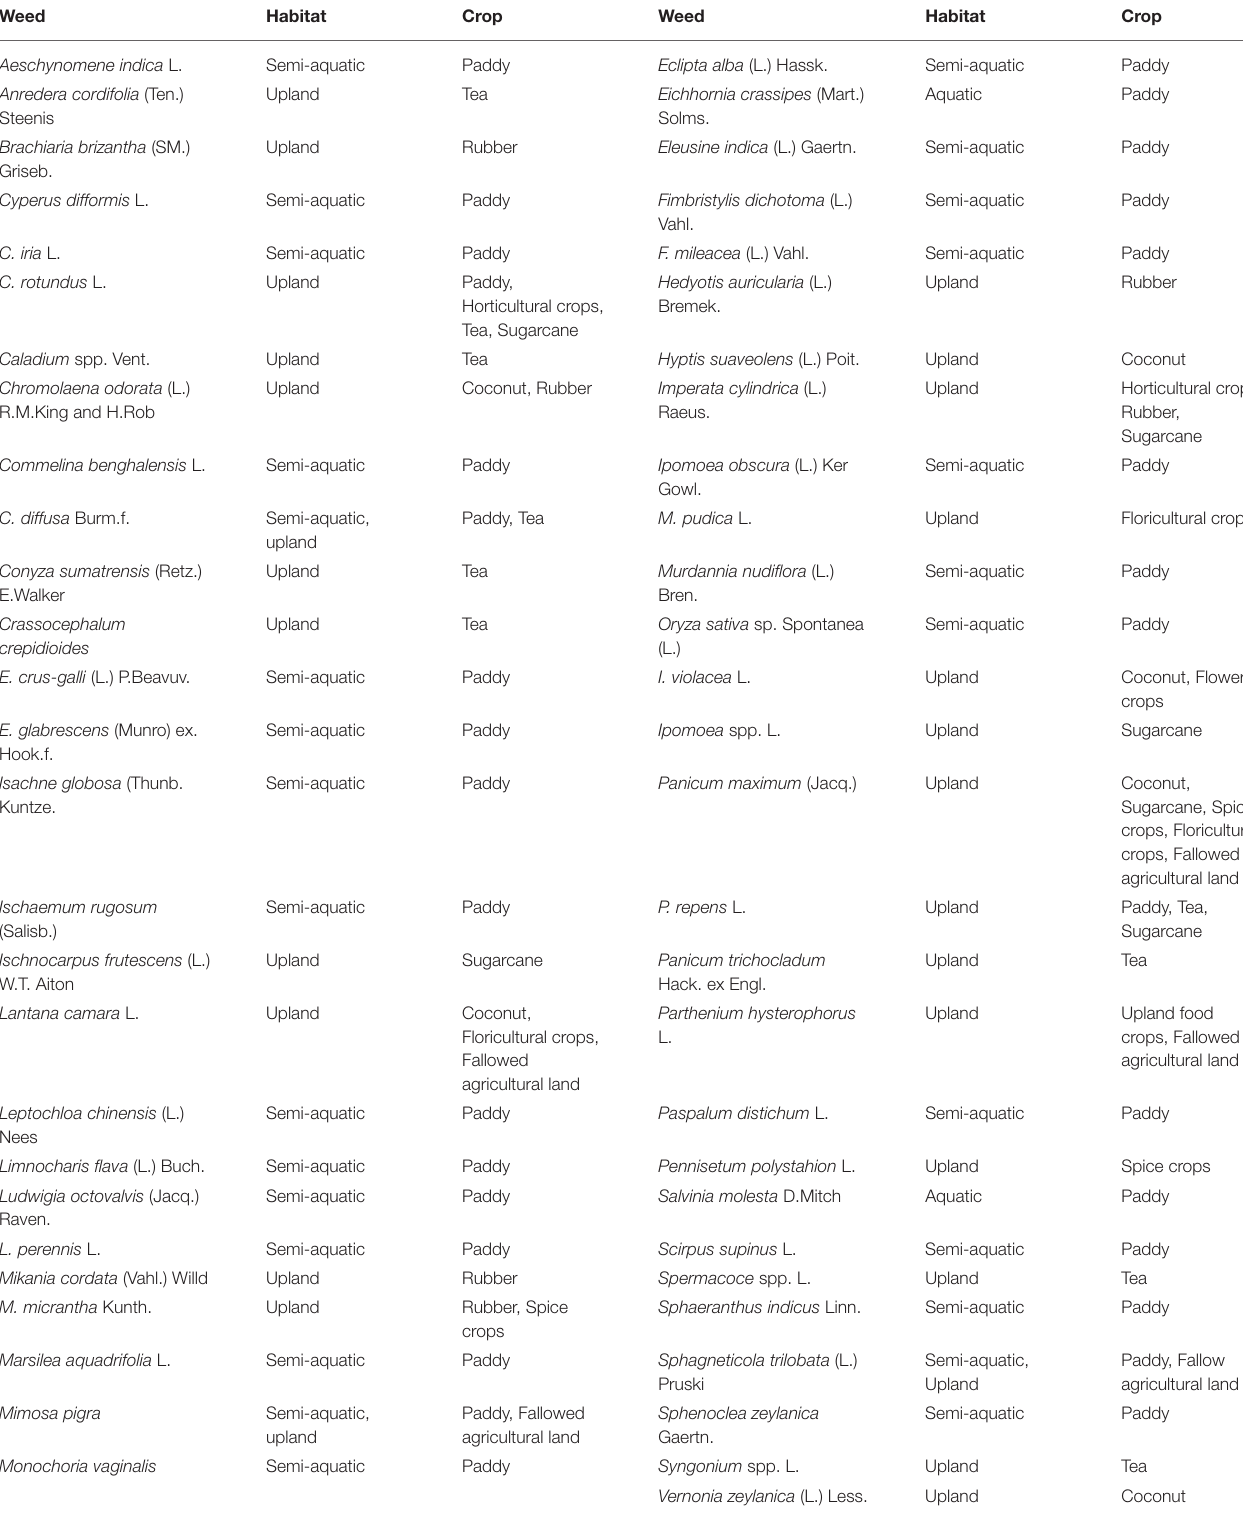
TABLE 3 | Weeds of National Significance in Sri Lanka (source: SLCARP, 2017).